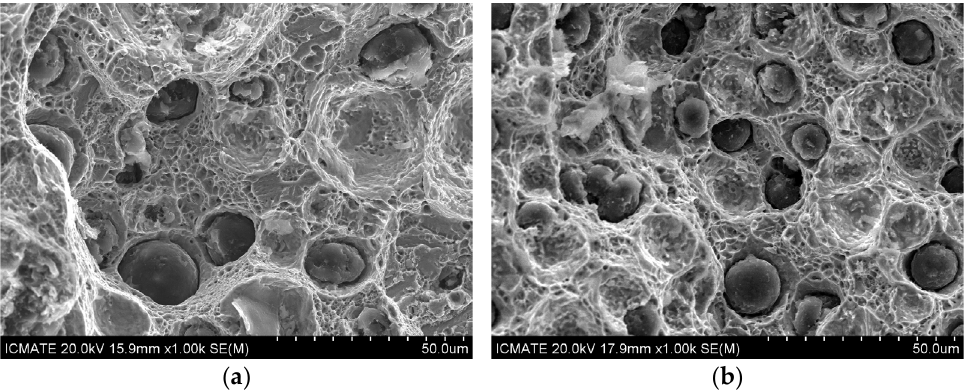
Figure 7. Selected SEM micrographs through SEI of tensile specimen fracture surfaces of ADI with 0.0 wt% of Ni produced in 25 mm Y-blocks after austempering at 310 °C for 3 h: ( a ) fracture surface from round tensile specimen; ( b ) fracture surface from flat tensile specimen.